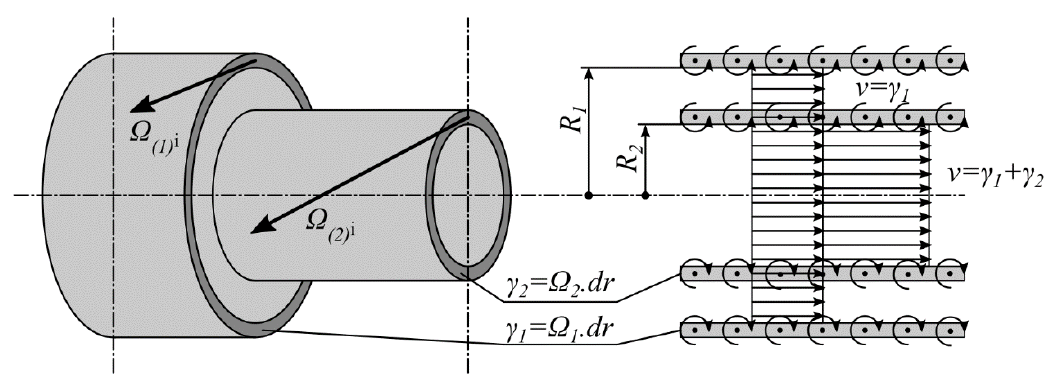
Figure 3. Interaction of two concentric circular vortex sheets.